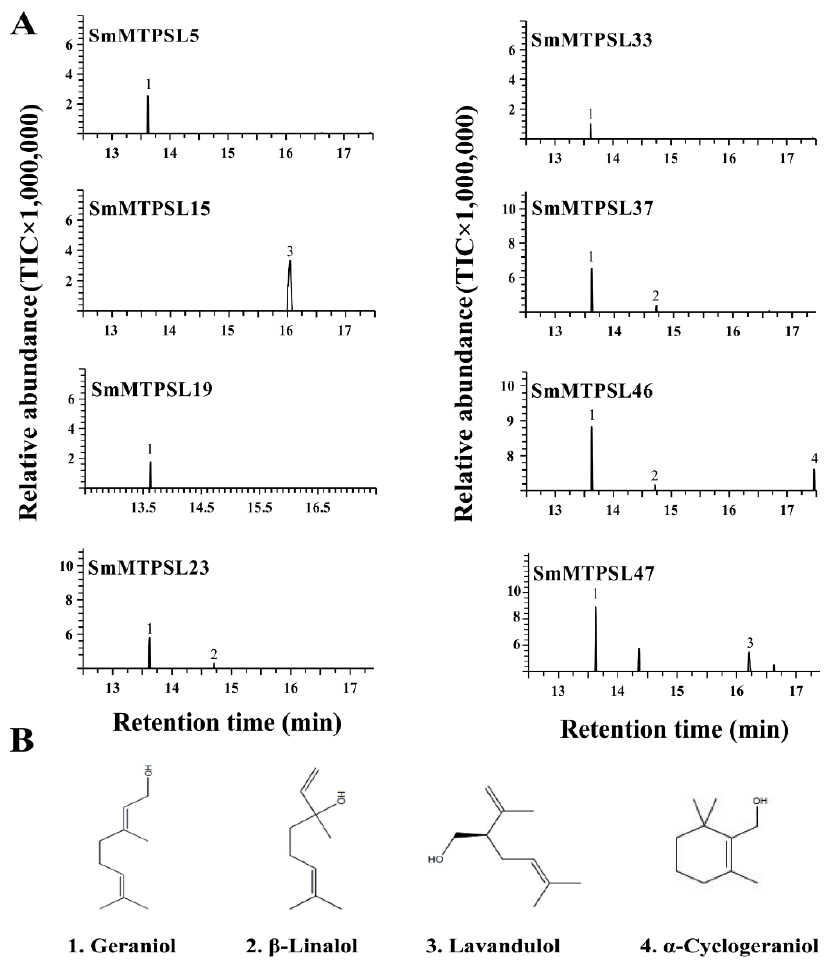
Figure 4. GC-MS of the products generated in vitro by eight recombinant SmMTPSLs proteins provided with GPP as the substrate. ( A ) Total ion chromatogram of the monoterpene products and ( B ) their structure. Products were identified as 1: geraniol; 2: β-linalool; 3: lavandulol; 4: a-cyclogeranio.